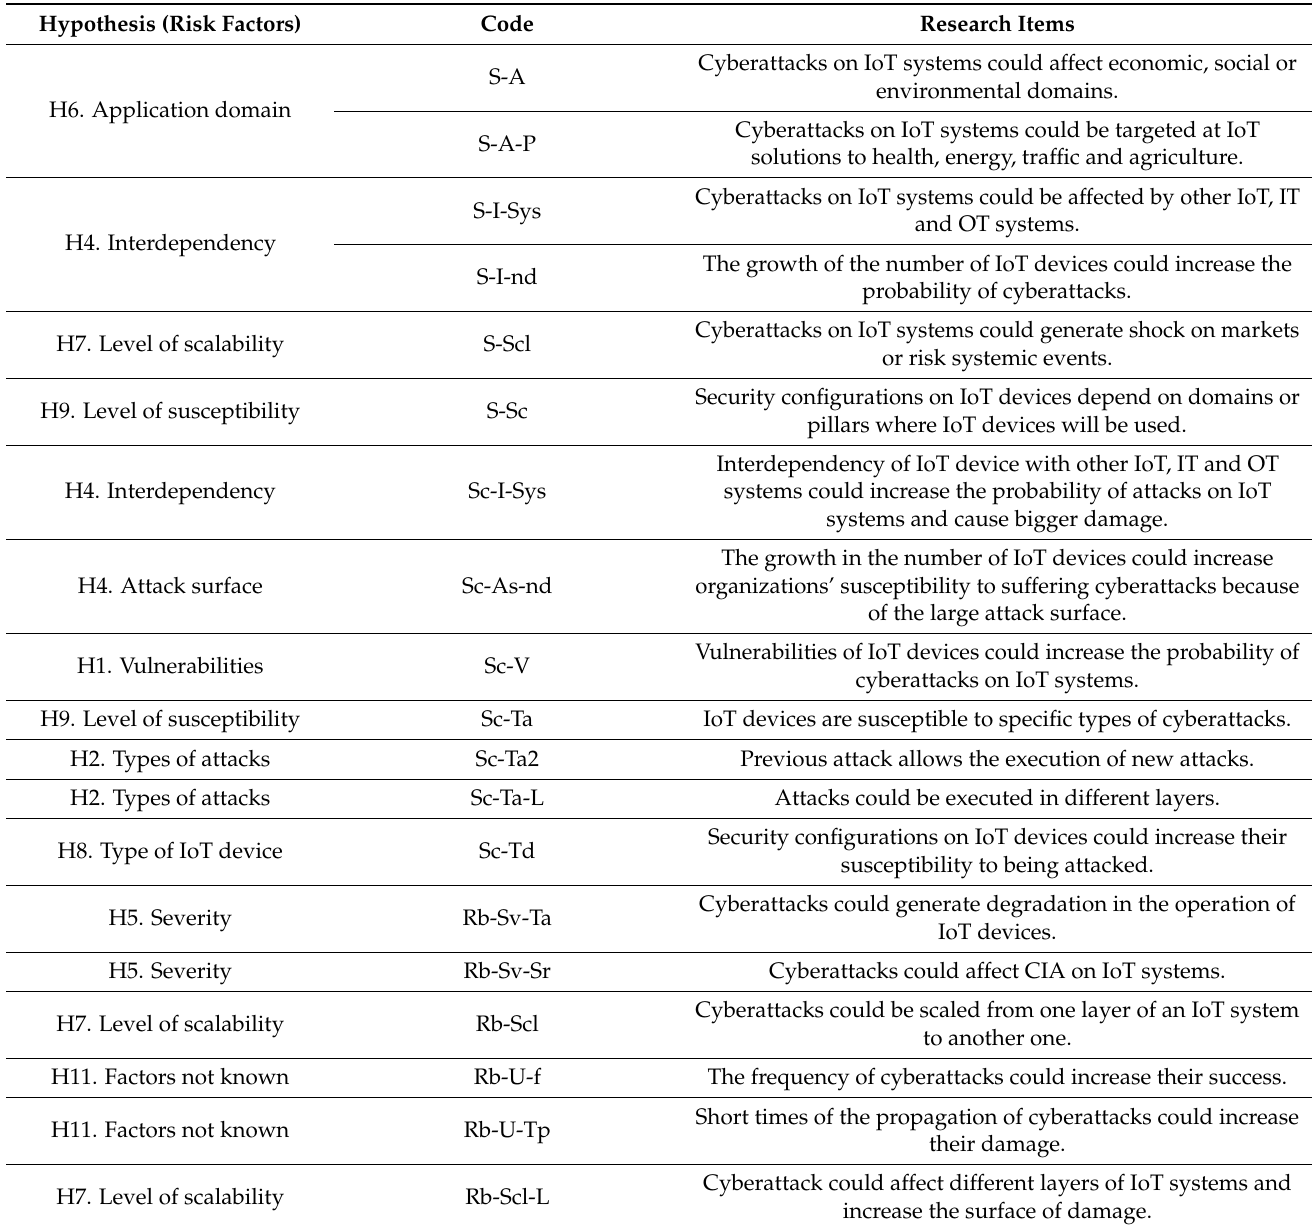
Table 5. Research items validated in experimentation to identify the relationships between factors of IoT